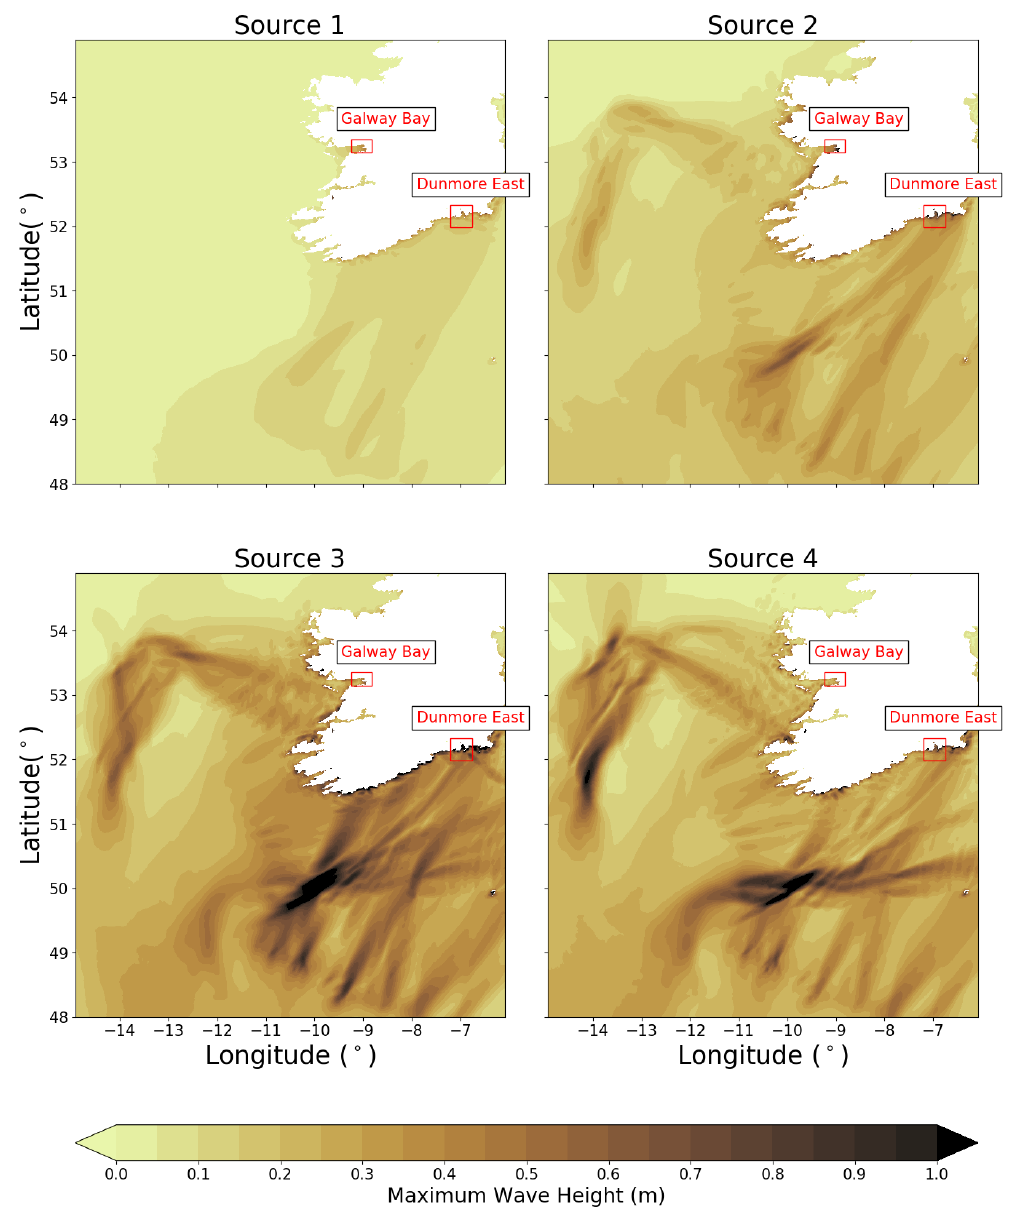
Figure 4. Zoom in on the maximum wave heights simulated for the four sources around the coast of Ireland. The areas of interest are highlighted in each